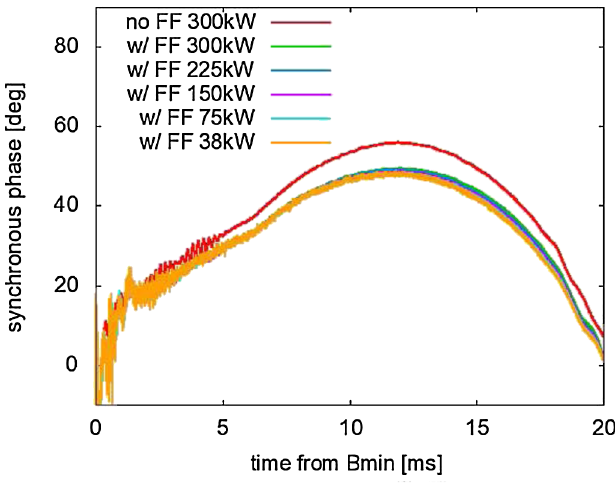
FIG. 19. (cid:1) comparison with and without the feedforward. s